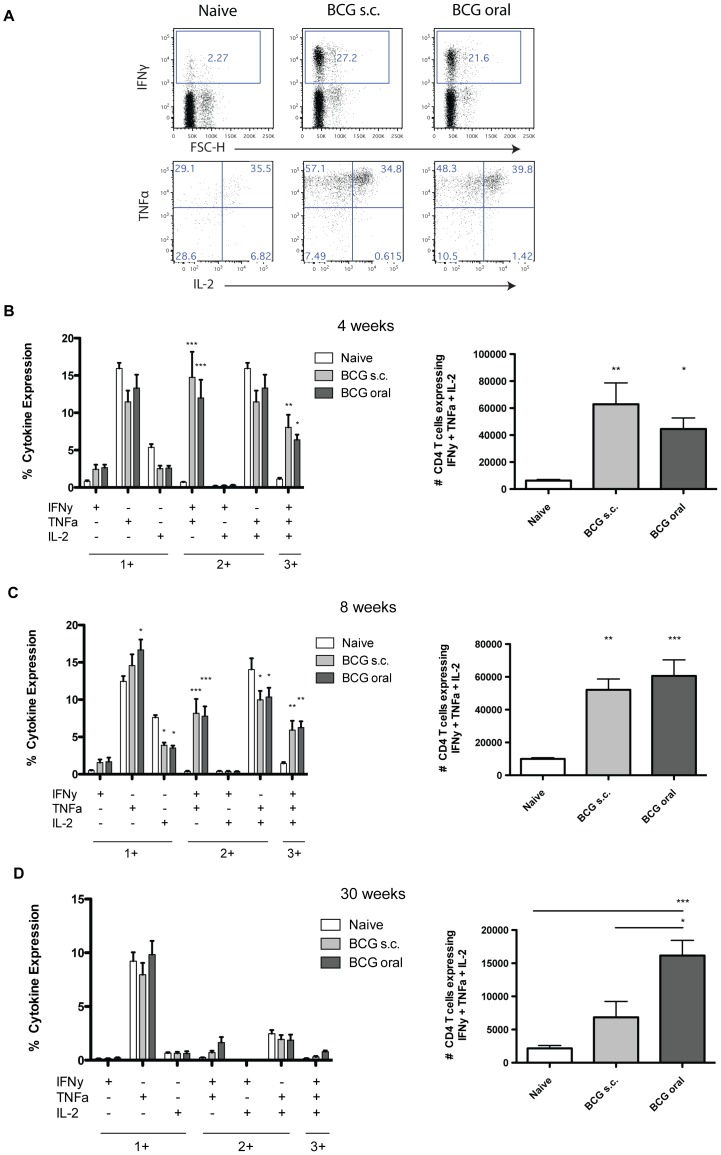
Increased multifunctional CD4+ T cells in the lungs of Liporale™-BCG vaccinated mice.Lymphocytes from the lungs of naïve, Liporale™-BCG vaccinated (BCG oral) or subcutaneous vaccinated (BCG s.c.) mice were stimulated for 6 hours in the presence of Brefeldin A and monensin then analyzed by flow cytometry. (A) Representative dot plots of CD4+ T cells from the lungs of naïve or BCG vaccinated mice expressing IFNγ, TNFα or IL-2 cytokines. Multifunctional cells were identified by first gating on IFNγ+ cells, and then on cells positive for both TNFα and IL-2. (B) Bar graph showing the percentage of CD4+ T cells from naïve or BCG vaccinated mice producing 1, 2 or 3 cytokines simultaneously, and bar graph of the frequency of multifunctional CD4+ T cells in the lungs of naïve or vaccinated mice at 4 weeks post immunization. (C,D) Bar graphs as in (B), but showing results for 8 and 30 weeks post vaccination, respectively. Results are displayed as mean + SEM of n = 5 for each group, significance expressed relative to naïve: *p<0.05, **p<0.01, ***p<0.001 (two way ANOVA with Bonferroni post test (Figure 5a, b and c, left graphs), one way ANOVA with Tukey post test (Figure 5a, b and c, right graphs)). Eight and 30 weeks results are representative of 2 independent experiments.